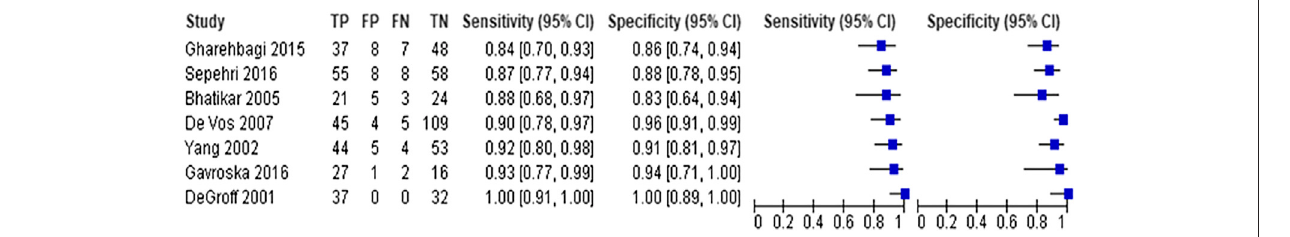
Frontiers in Arti fi cial Intelligence |